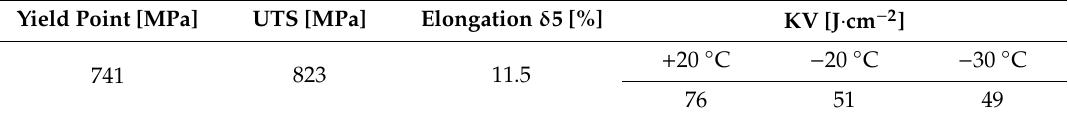
Table 2. Mechanical properties of the Strenx 700 MC obtained by tensile test and Charpy impact test.